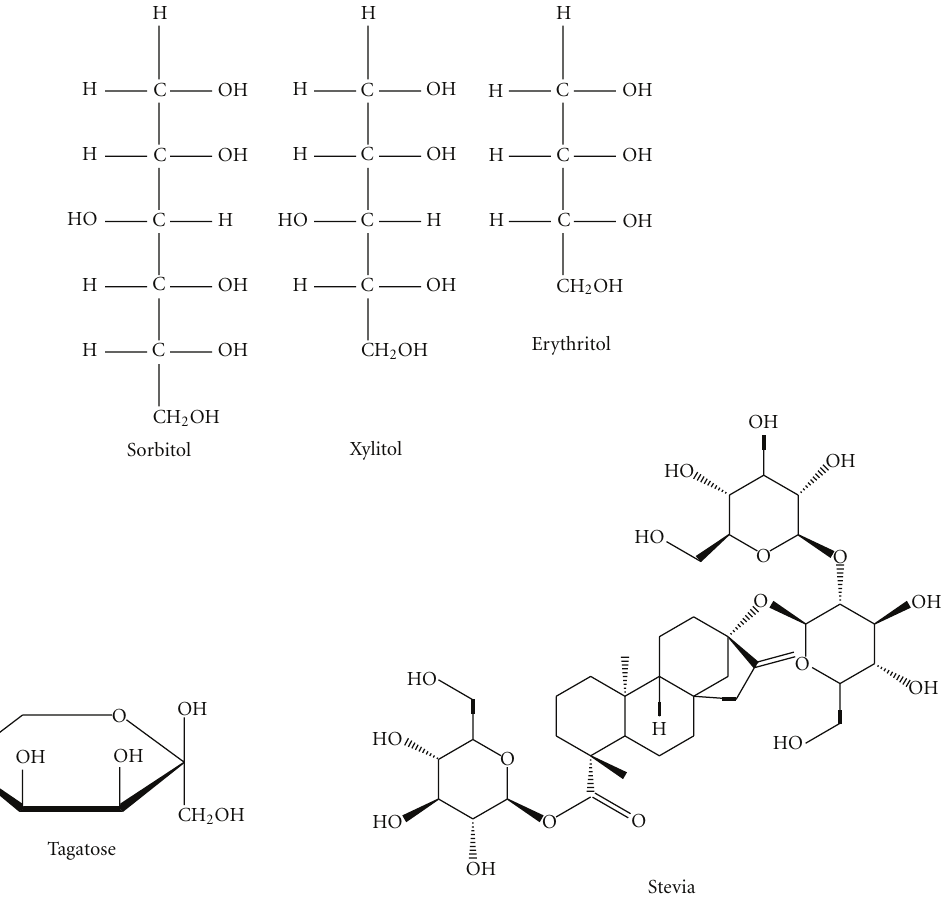
Figure 2: Chemical structure of FDA approved non-/low caloric sweeteners as GRAS (Generally Recognized as Safe). versus 4 calories per gram). Erythritol has been used in